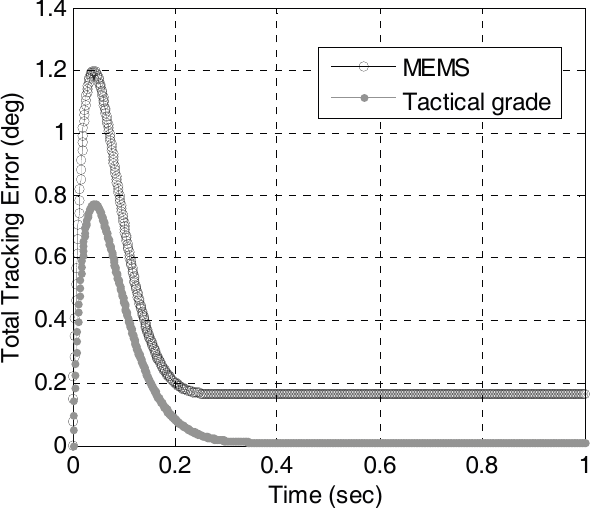
Figure 10. Total carrier phase tracking errors caused by the maneuver-independent velocity errors of different grades of